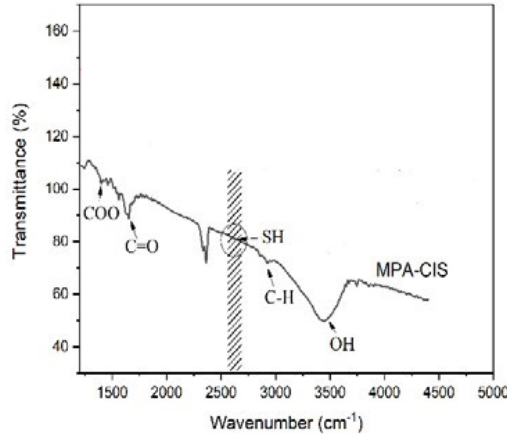
QDs Fig. 7. FTIR analysis of MPA-capped CuInS 2 Fig. 7: FTIR analysis of MPA-capped CuInS 2 QDs